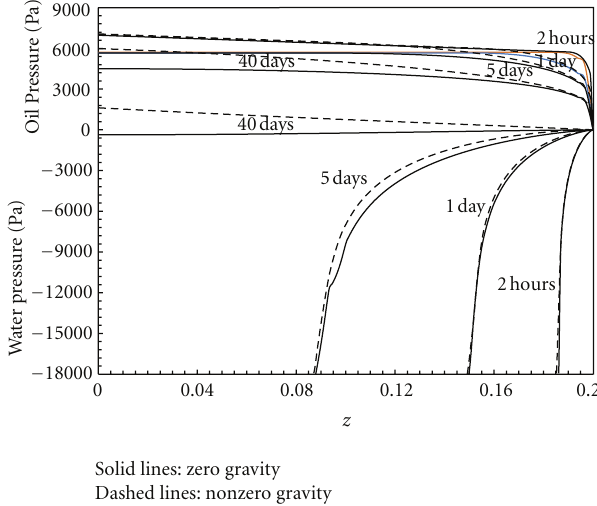
Solid lines: zero gravity Dashed lines: nonzero gravity Figure 6: Comparison between considering and neglecting gravity e ff ect on water x -velocity against x -axis of Case A, at z = 0 . 15 m.